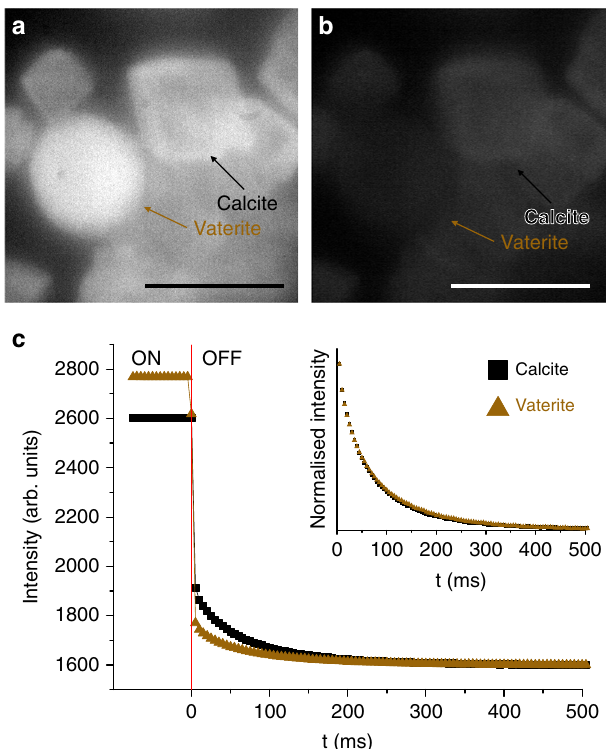
Fig. 6 Dependence of room temperature phosphorescence activation on the crystal phase. Time-resolved phosphorescence microscopy images with UV excitation ( a ) on and ( b ) 5 ms after the removal of UV excitation, and ( c ) intensity vs time plots for calcite (black square) and vaterite (brown triangle)-based RTP nanocomposites. The plot in ( c ) shows the intensity with UV light on and off, and the point at which the light is removed is shown with a vertical red line at t = 0. The normalised decay curves for calcite and vaterite overlap, indicating identical phosphorescent lifetimes (inset; scale bar 50 μ